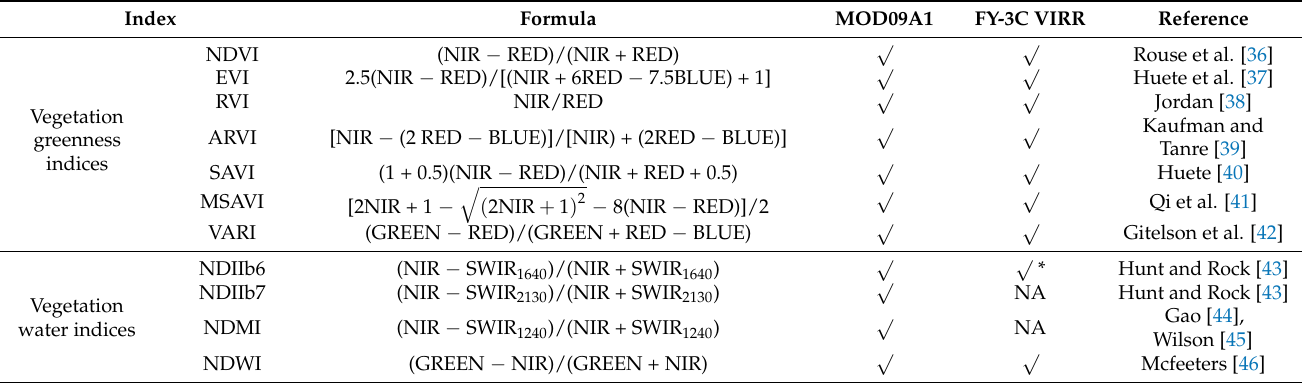
Table 2. The vegetation indices derived from MOD09A1 and FY-3C VIRR imagery.